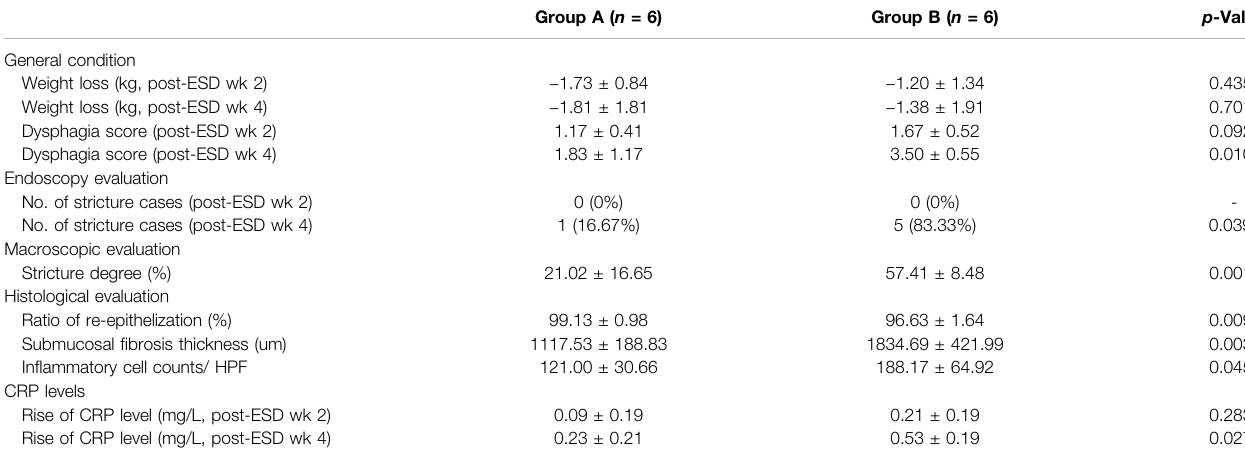
TABLE 2 | Physical, endoscopic, histologic, and biological comparisons between both groups.